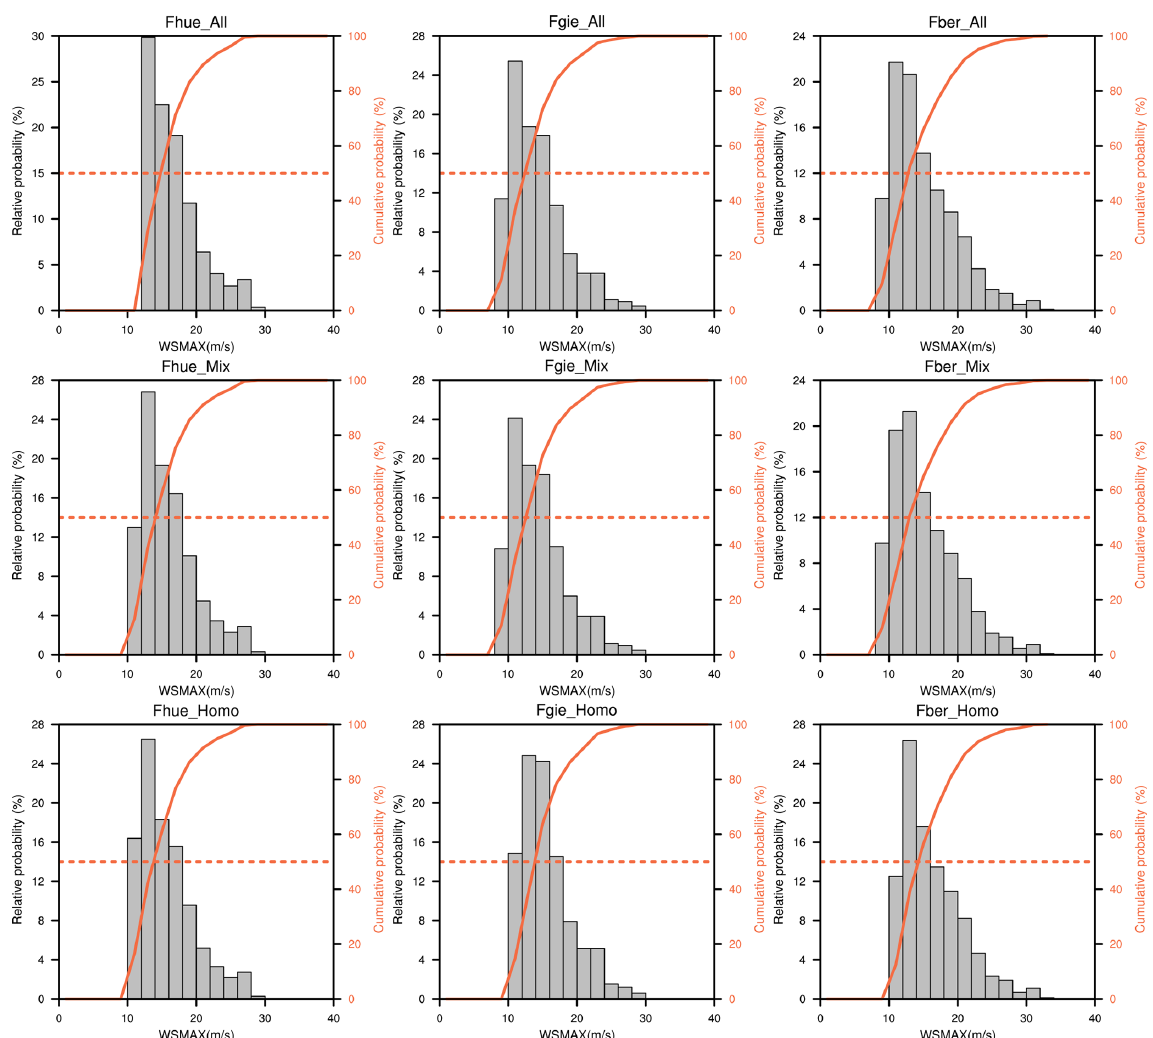
Figure 11. The same as Fig. 6 but only for the DTM constructed based on observations from all stations (All) and observations from five stations with a heterogeneous distribution (Mix) and homogeneous distribution (Homo) of feature variables, respectively. DTMs were assessed at stations with relatively high maximum wind speed (Fhue) and with relatively low maximum wind speed (Fgie and